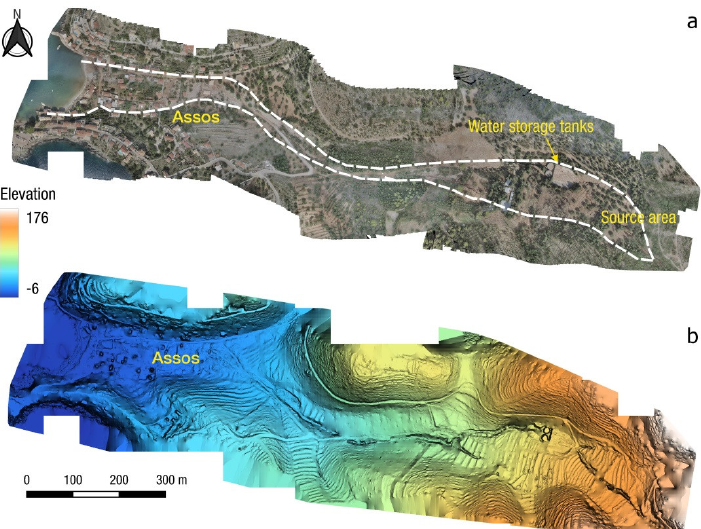
Figure 12. UAS-enabled mapping of Assos village debris flow and surrounding area (3D model can be viewed at: https://skfb.ly/6WyTT (accessed on 2 July 2022)): ( a ) orthophotomap and ( b ) digital surface model (surveyed on 30 September 2020).